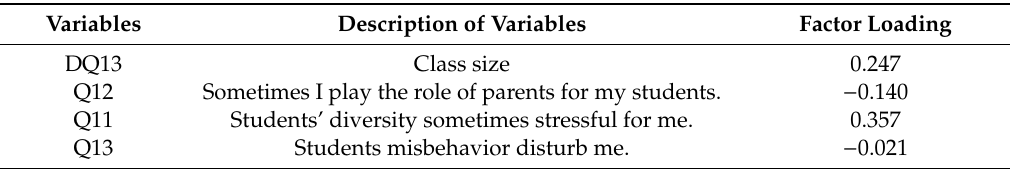
Table 7. Standardized direct e ff ects of STUDENT.